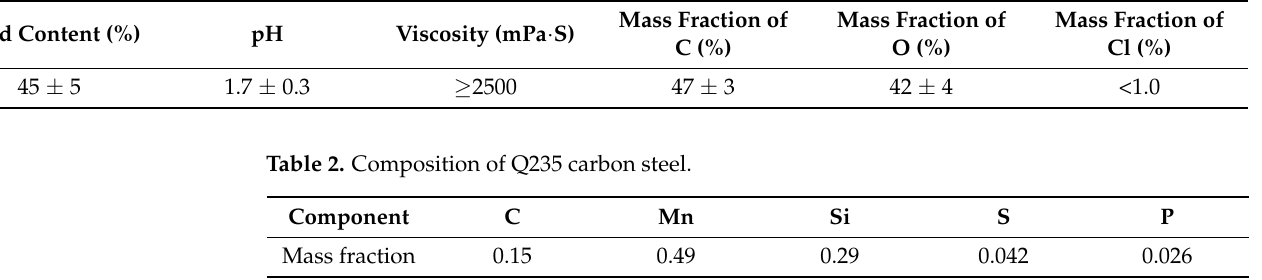
Table 1. Basic performance parameters of graphene oxide.